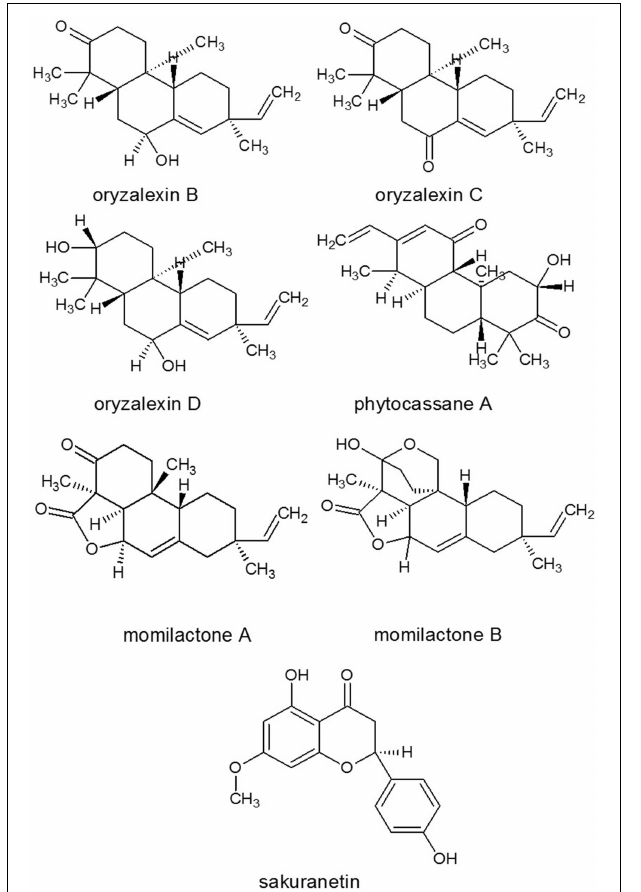
FIGURE 8 | Structures of some phytoalexins isolated from rice. Source: National Center for Biotechnology Information. PubChem Compound Database (accessed Jun. 6, 2015) ( Bolton et al., 2008).